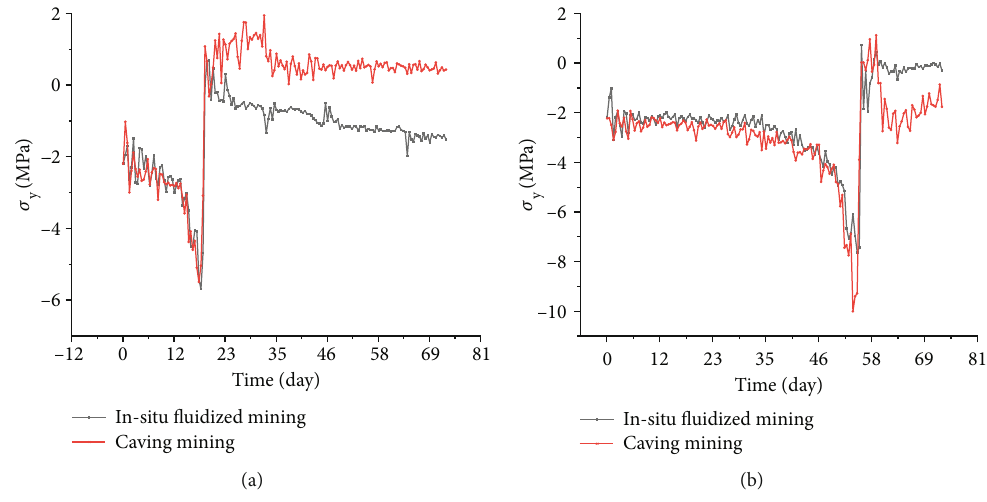
Figure 12: Evolution of the vertical stress component σ